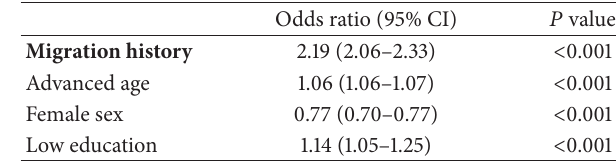
Table 1: Baseline characteristics of study subjects. Table 2: Adjusted Odds Ratio (OR) for presence of diagnosed chronic diseases/risk